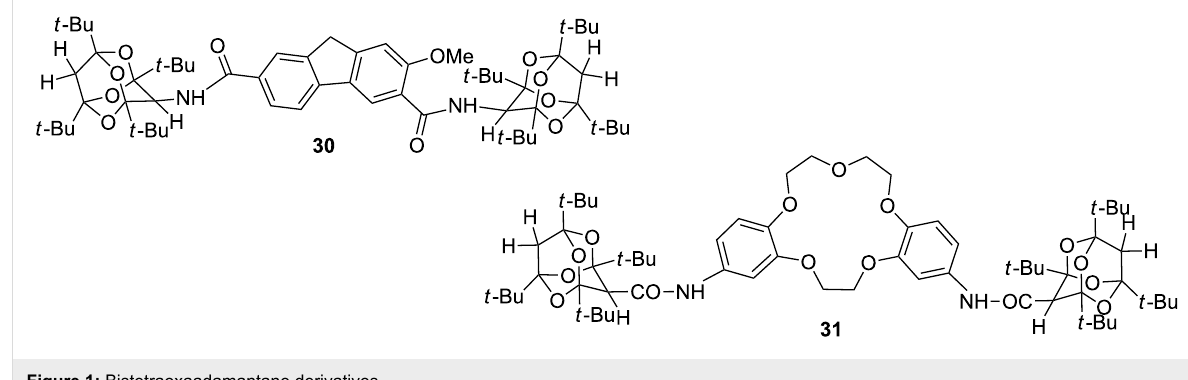
Figure 1: Bistetraoxaadamantane